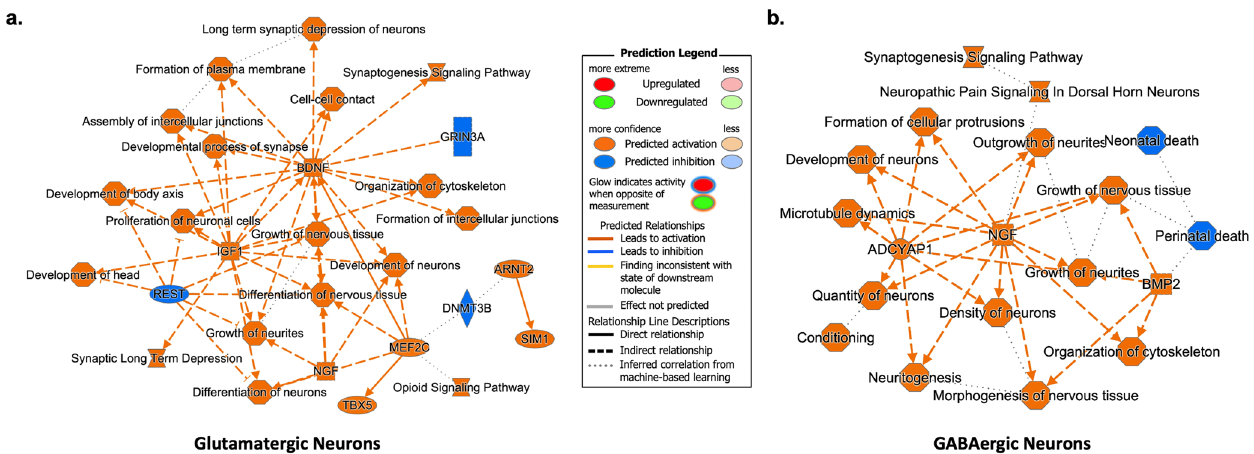
Fig. 2 Pathway enrichment analysis of differentially expressed genes from glutamatergic and GABAergic neurons. A machine learning algorithm implemented through Ingenuity Pathway Analysis (IPA) agnostically identi fi es pathways and molecules relevant to memory function in ( a ) glutamatergic and ( b ) GABAergic neurons. Note that the legend may include predicted events not observed within the constructed